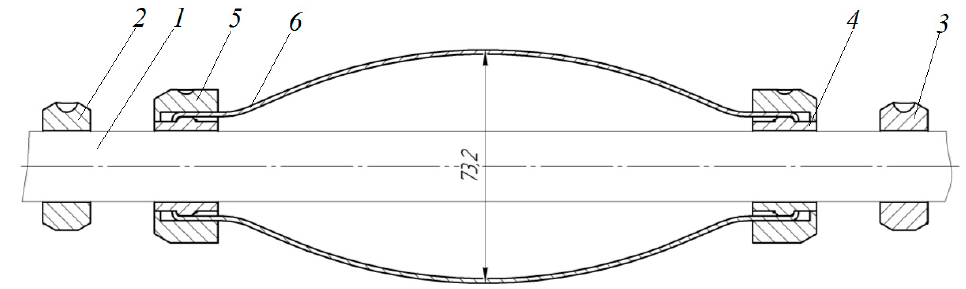
Figure 5. Effect of the upper reduced disc’s weight on the circular speed in well no. 3633.